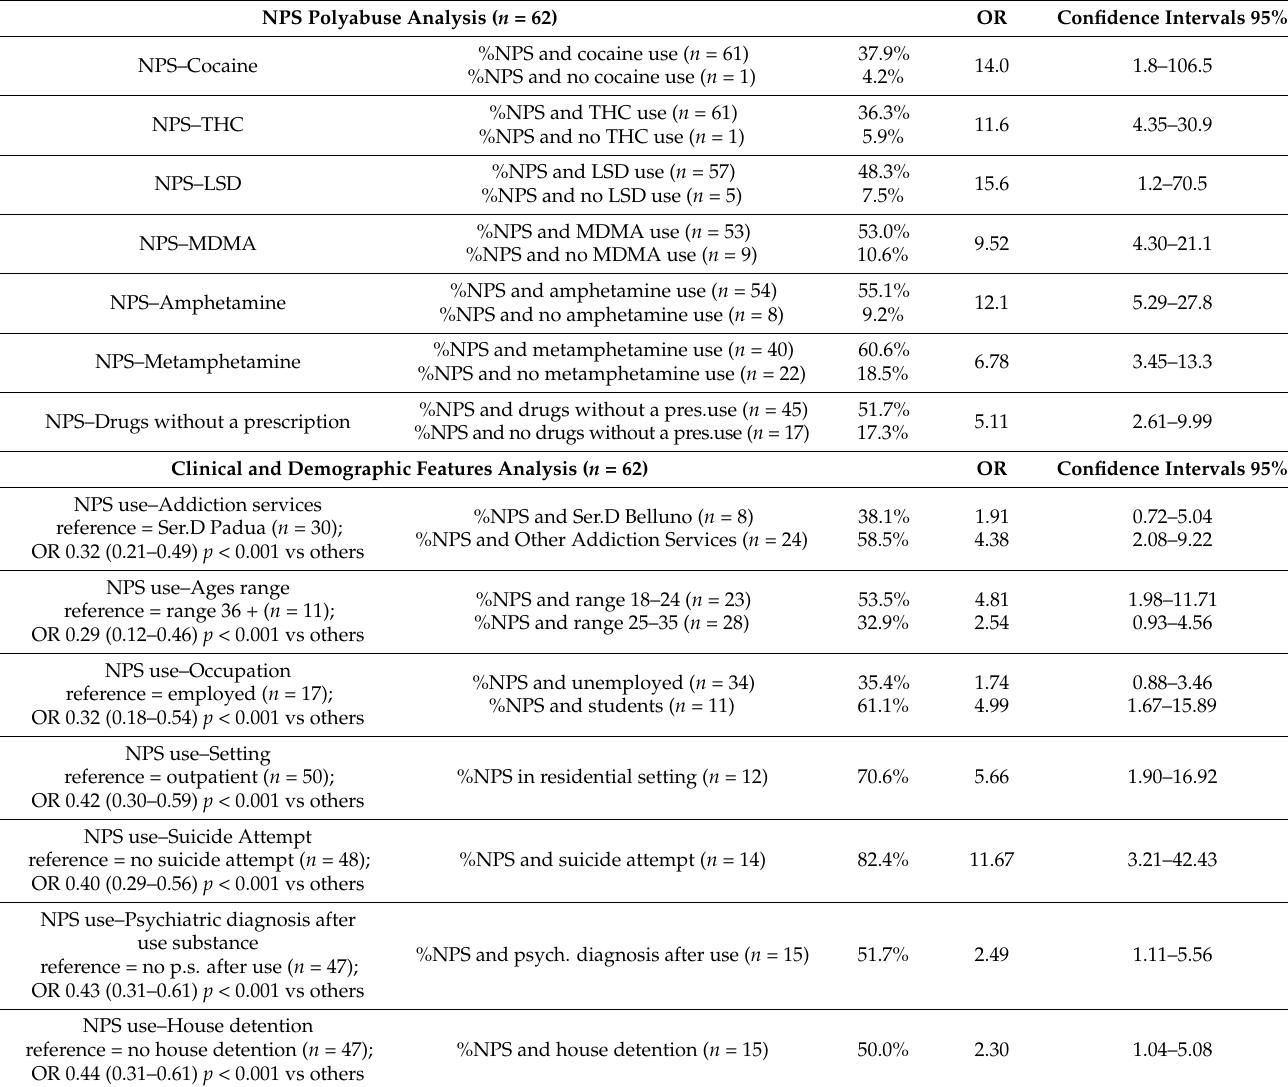
Table 4. Factors associated with use of novel psychoactive substances (NPS).